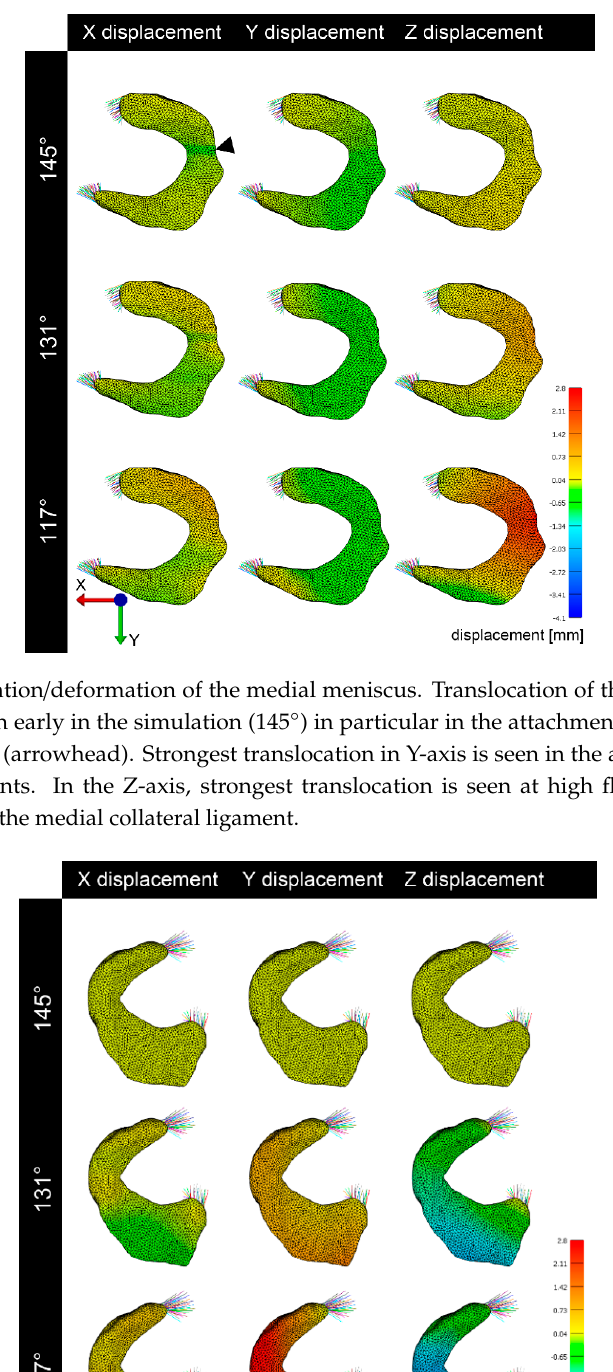
Figure 5. Displacement of ten virtually marked points at the peripheral contour of the medial meniscus during simulation.